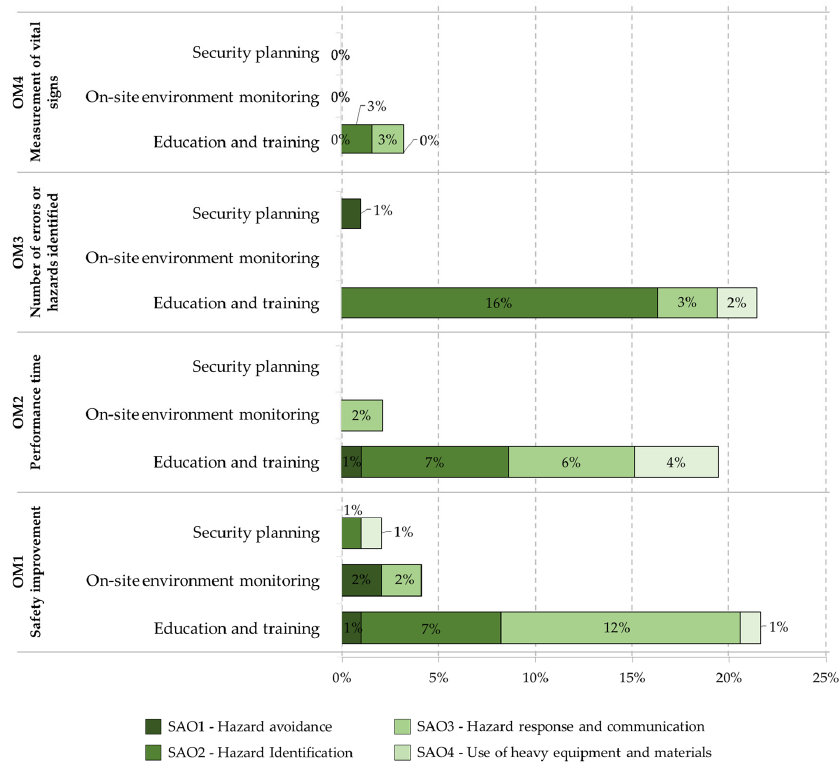
Figure 10. Number of items of each safety application objective for each purpose related to the types of evaluation of the target method.